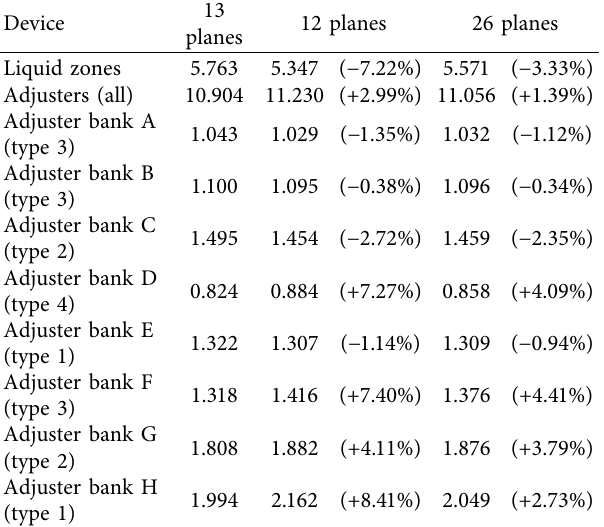
Table 5: Efect of core nodalisation on reactivity device worths (in mk).